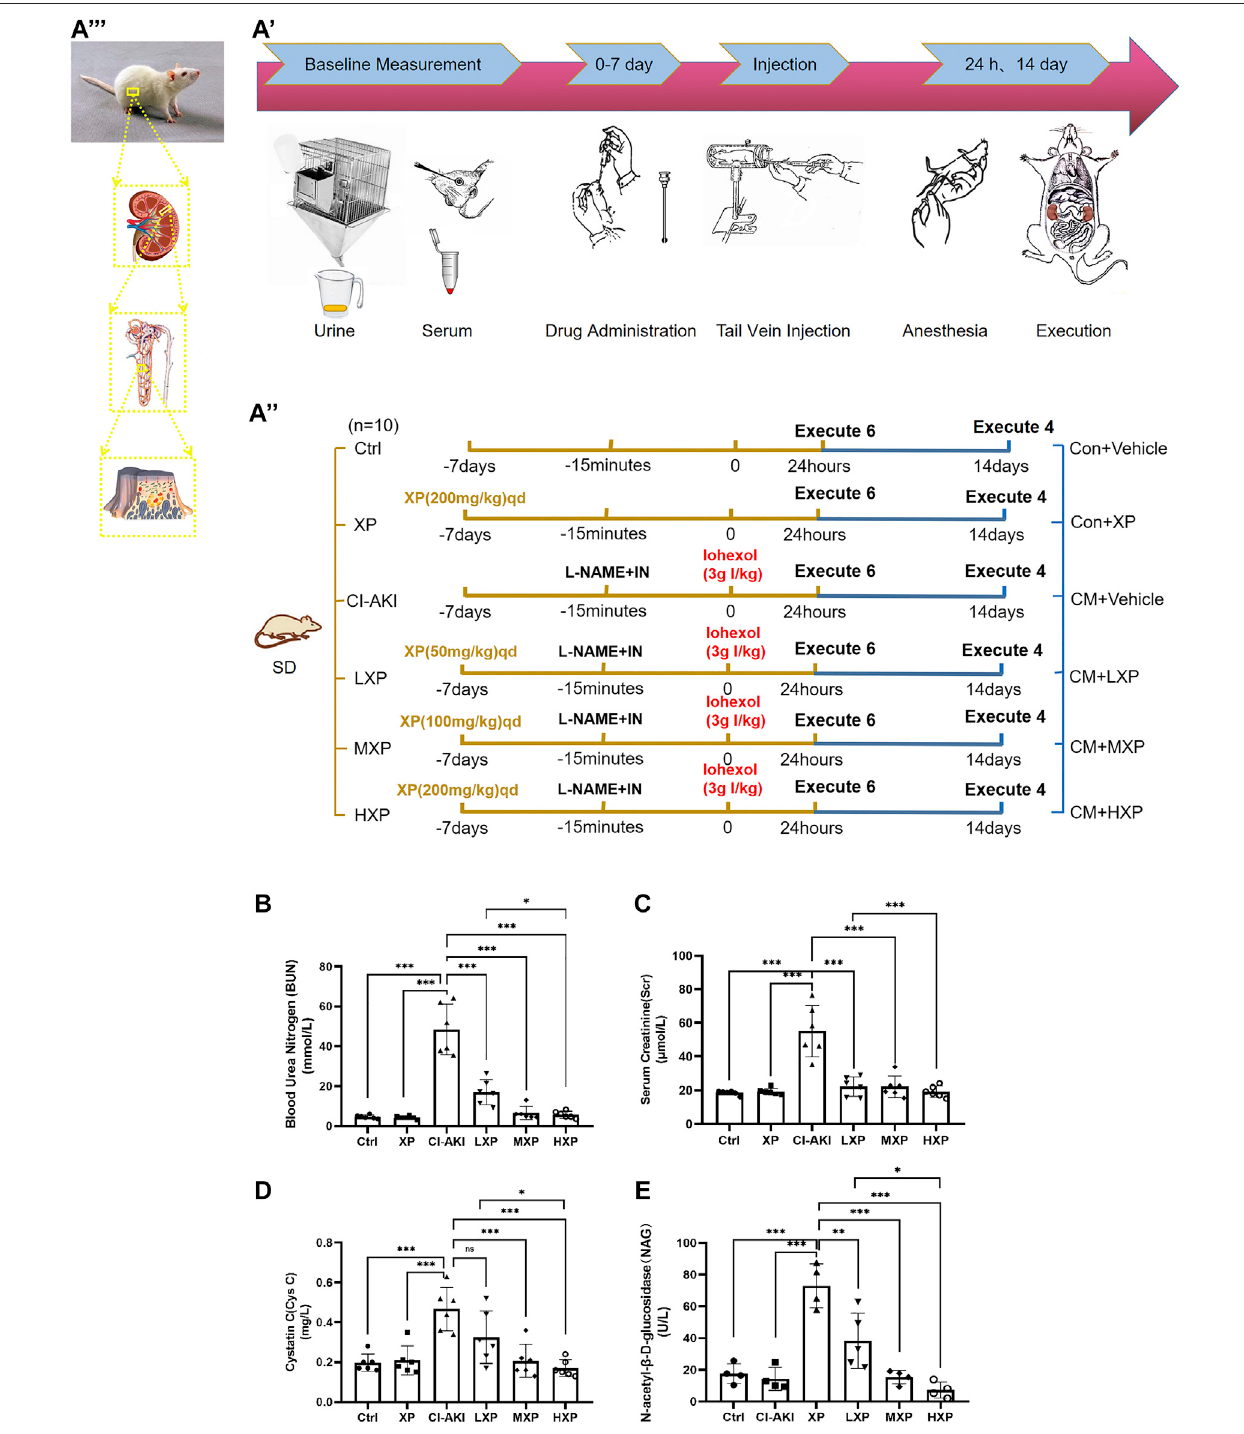
FIGURE2| XPattenuatesiohexol-inducednephrotoxicityinrats. (A) Diagrammaticrepresentationoftheinduciblestrategyincontrast-inducedacutekidneyinjury(CI-AKI)rats. (B) Experimentalprocessdiagram(Firstly,atotalof60ratswererandomlydividedintosixgroups:shownastheleftgroups.TheratswereadministratedwithorwithoutXPorallyfor sevenconsecutivedaysbeforeapplyingiohexol.ThenCMwasadministratedtoappropriaterats.24haftercontrastadministration,sixanimalsofeachgroupwerechosenrandomly andanesthetized,collectedbloodforcon fi rmationofAKI,andkidneysremovalforfurtherexperiments.14daysafterIohexol,theleftfourratsweremeasured fi brosisdegree.In ordertodistinguishthegroupsfromtheformer,theirnameswerechangedastherightpart). (C) experimentalsubjectdiagram.IohexolcausedrenaldysfunctionintheCI-AKIgroup, whiletheco-administrationofXPdecreasedthelevelofBUN(B),Scr (C) ,CysC (D) anduNAG (E) .Resultsarepresentedasmean ± SEM( n (cid:1) 6ineachgroup).* p < 0.05;** p < 0.01; *** p < 0.001basedonone-wayanalysisofvariance.Scr,serumcreatinine;BUN,bloodureanitrogen;CysC,cystatinC;uNAG,urinaryN-acetyl- β -D-glucosidase;Ctrl,control;CI-AKI, contrast induced-acute kidney injury; LXP, low dose XP combined with iohexol; MXP, medium dose XP combined with iohexol; HXP, high dose XP combined with iohexol.